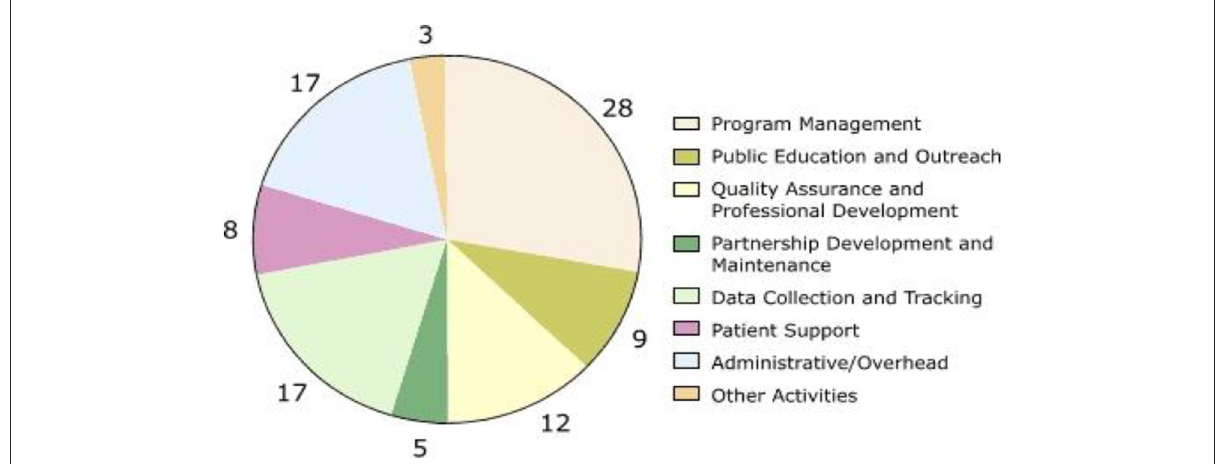
FIGURE1 Percentage distribution of start-up costs, by activity, averaged across the five programs in the Colorectal Cancer Screening Demonstration Program, 2005–2006. Numbers do not add up to 100% due to rounding.